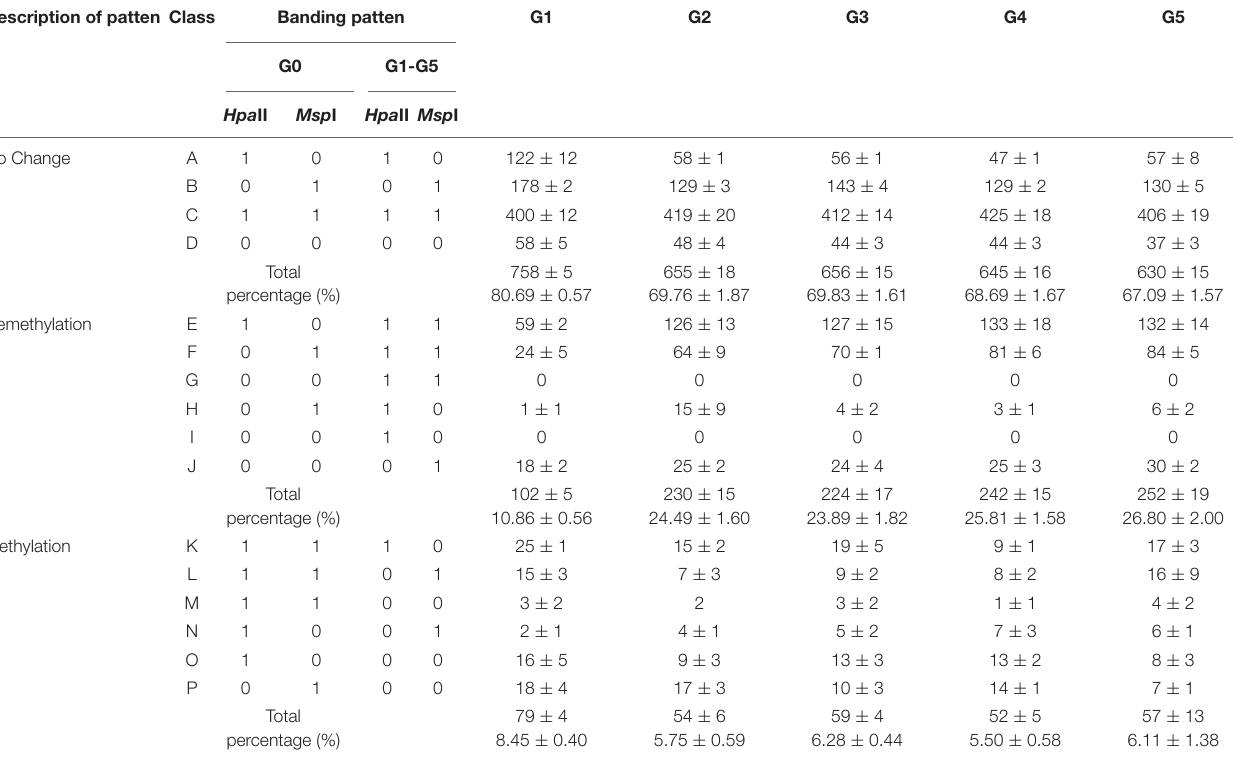
TABLE 2 | Analysis of DNA methylation patterns in regenerated plants of five generations compared with donor plants. Description of patten